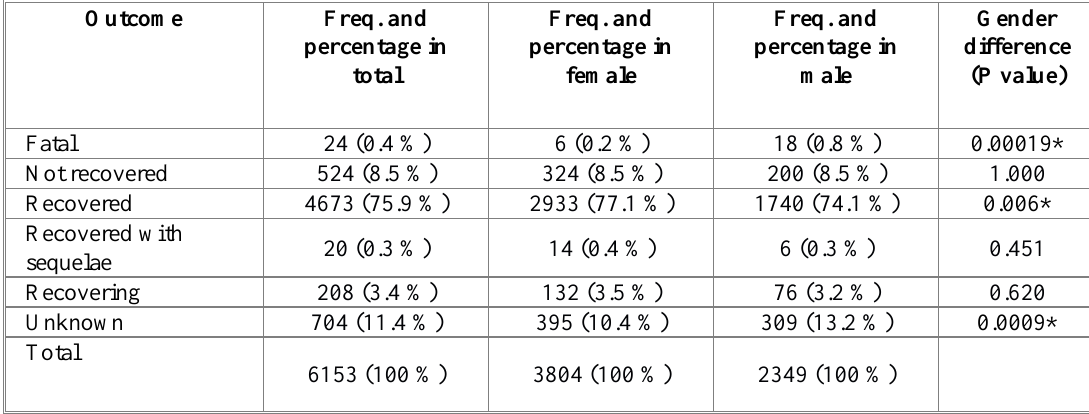
Table 5. Outcome of the ADR for each gender.